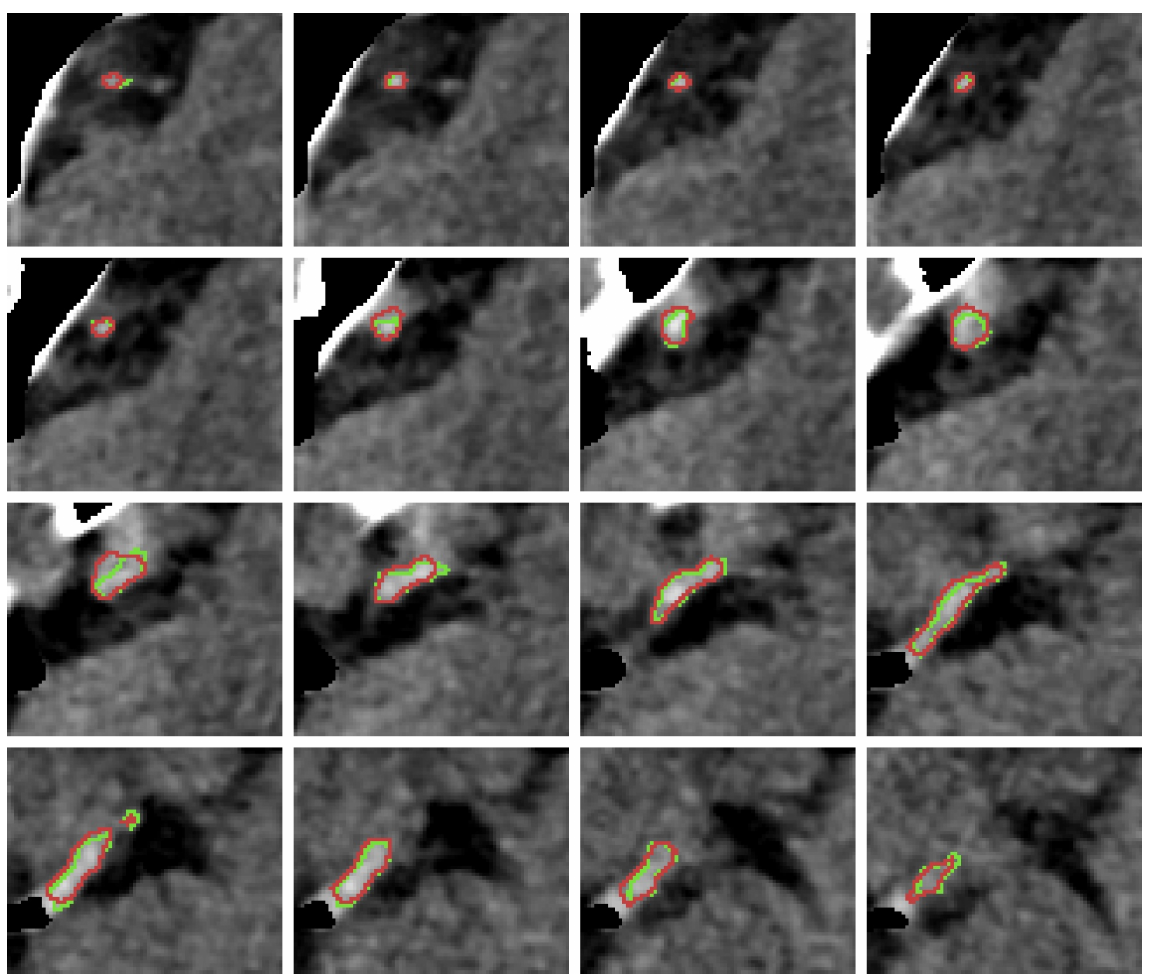
Figure A3. Slice-by-slice presentation of segmentation prediction and ground truth on NCCT in a bounding box for one patient with a high segmentation accuracy. Surface Dice of this prediction is 0.98 and Dice is 0.84. The contours of the ground truth annotation and segmentation prediction are shown in green and red,